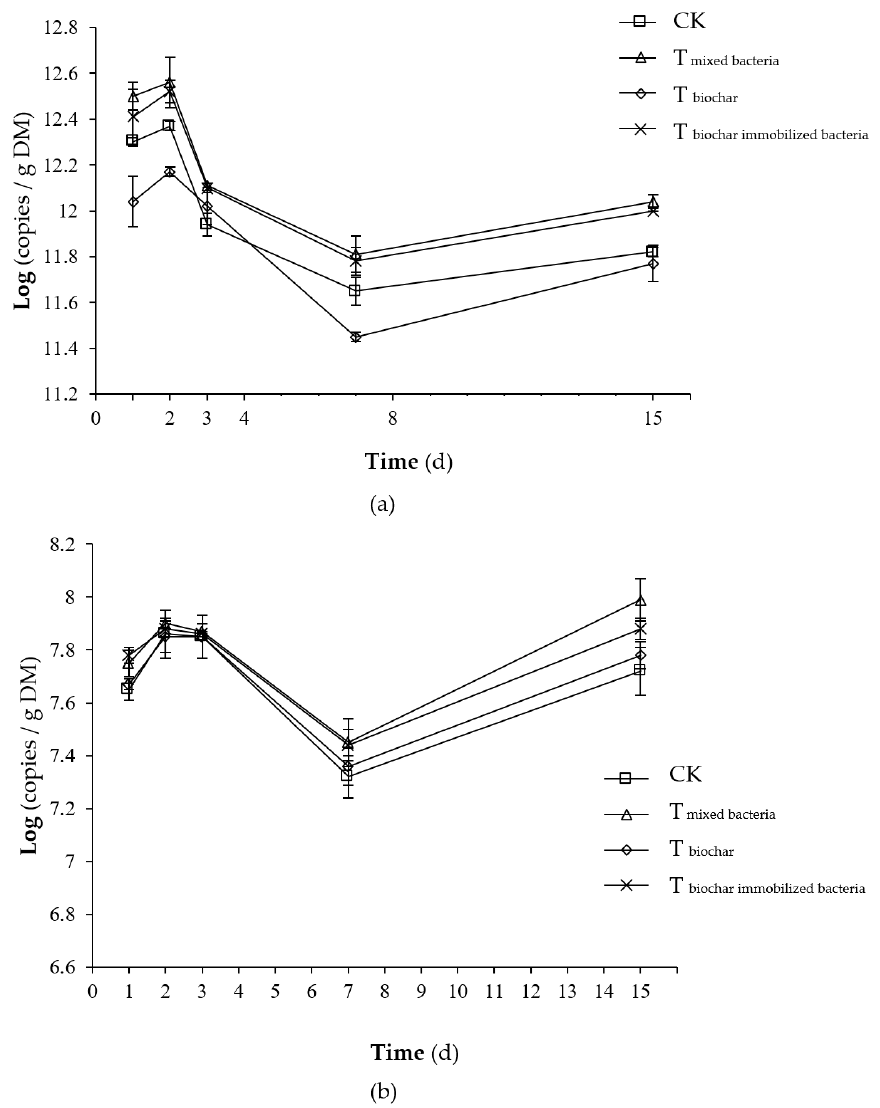
Figure 5. Total number of bacterial ( a ) and fungal ( b ) profiles for different composting treatments (CK: as the control); Note: Error bars represent the standard deviation ( n = 3). as the control); Note: Error bars represent the standard deviation ( n =